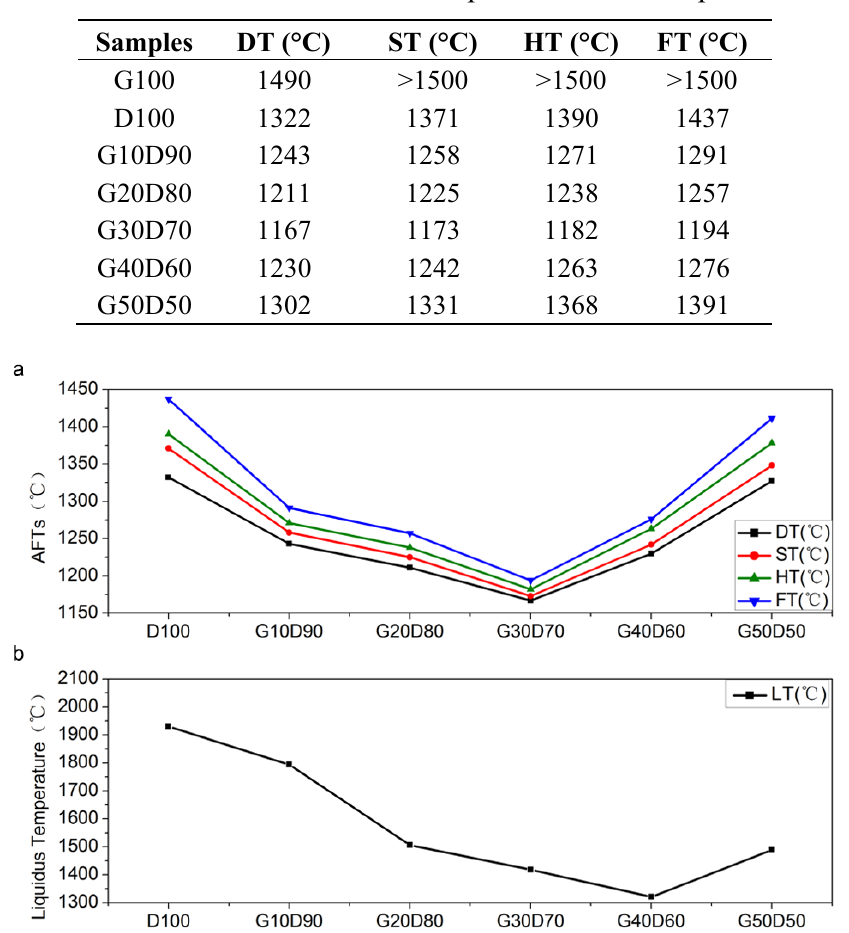
Figure 1. Comparison of ash fusion temperatures and liquid temperatures: ( a ) AFTs; ( b ) liquidus